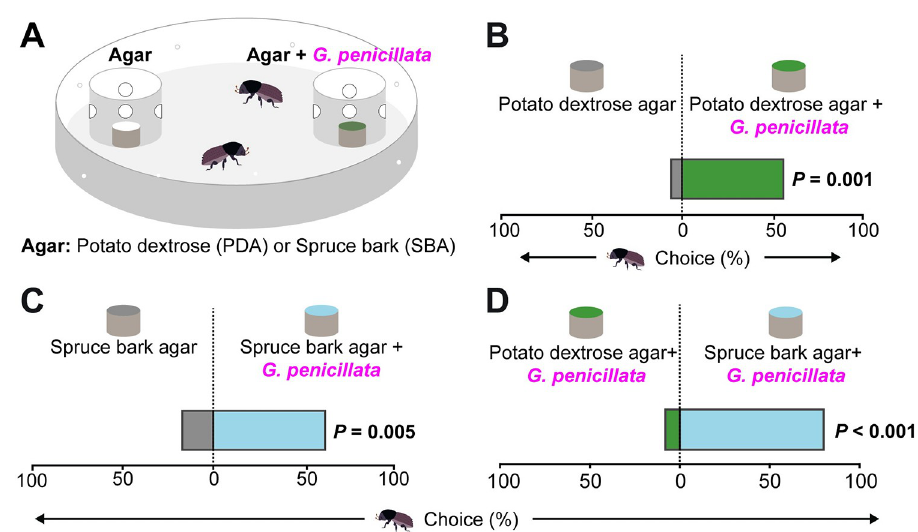
Fig 1. Ips typographus uses volatile cues from spruce bark inoculated with G . penicillata (Gp) to detect this symbiotic fungus. (A) Arena used for trap bioassays to study the behavior of I . typographus to volatiles emitted by a symbiotic fungus. Cups containing agar (with and without fungus) were offered to beetles as odor samples. Holes on each side of the cup allowed the beetles to smell but not touch the agar until they entered the cup and then could no longer escape. (B, C) Adult beetles chose Gp -colonized agar medium over fungus-free medium ( n = 25, with two beetles per replicate). (D) Adult beetles chose Gp -inoculated spruce bark agar over Gp -inoculated agar without spruce bark ( n = 25). (B–D) Deviation of response indices against zero was tested using Wilcoxon’s test. The data underlying this Figure can be found at